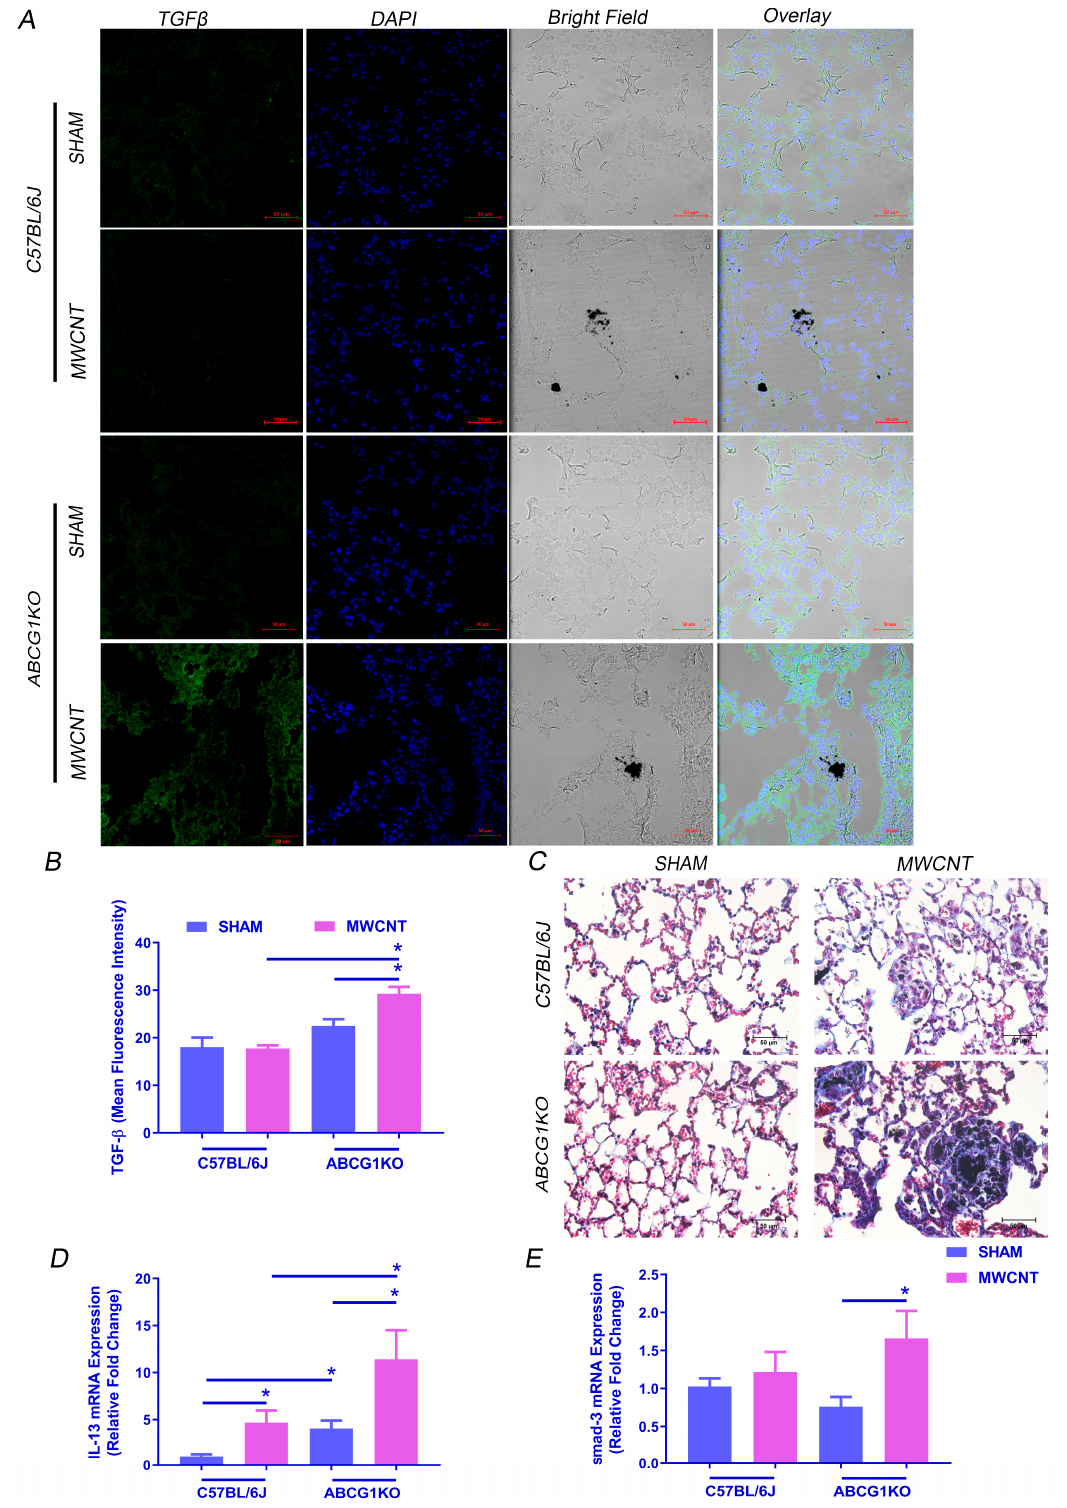
Figure 1. Myeloid ABCG1 deficiency increases fibrosis development and TGF- β expression in the lung of MWCNT instilled mice. ( A ) Representative images showing an increase in TGF- β expression in lung sections of MWCNT instilled ABCG1 KO mice. Lung sections from wild-type C57BL/6J mice or ABCG1 KO mice either sham- or MWCNT instilled were stained with TGF- β (green) and DAPI (blue). Bright field showing the presence of MWCNT in lung tissues. Scale bars: 50 µ m. ( B ) Graphical representation of TGF- β mean fluorescence intensities using Zen 3.1 blue edition. ( C ) Representative light